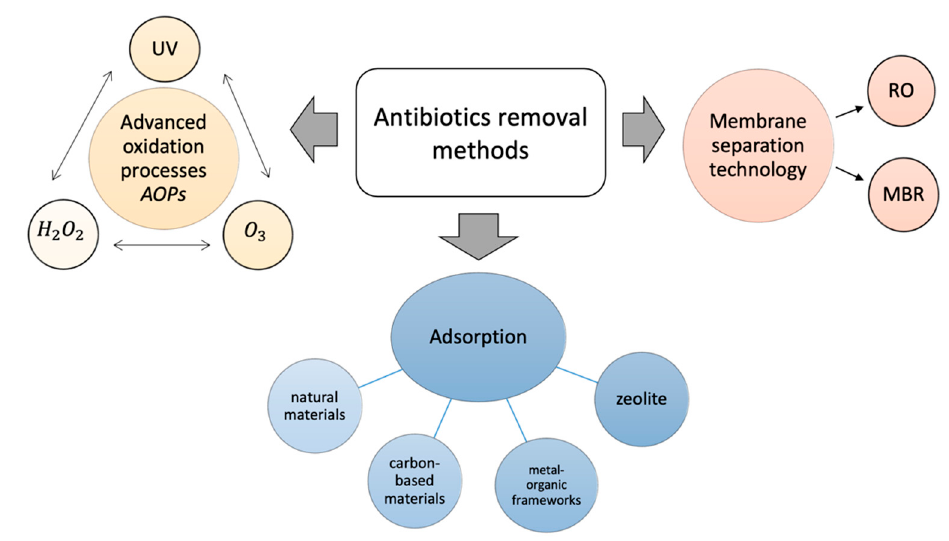
Figure 4. Scheme of advanced antibiotic removal techniques from wastewater.